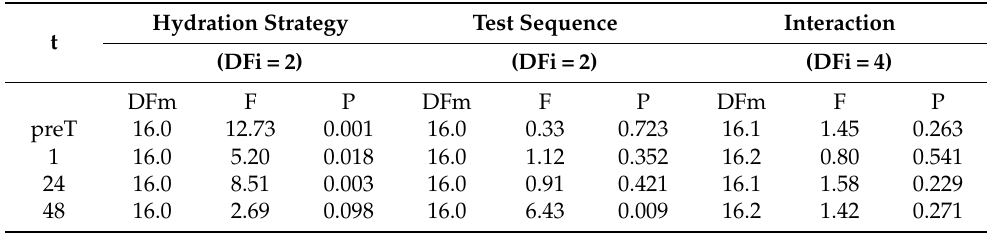
Table 10. Results of analysis of variance for lactate dehydrogenase measured before the test (preT) and 1, 24, and 48 h after the exercise test: significance of (P) and F-statistic along with the number of degrees of freedom (DFi—in the numerator; DFm—in the denominator) for the fixed effects (hydration strategy, test sequence, and their interaction).